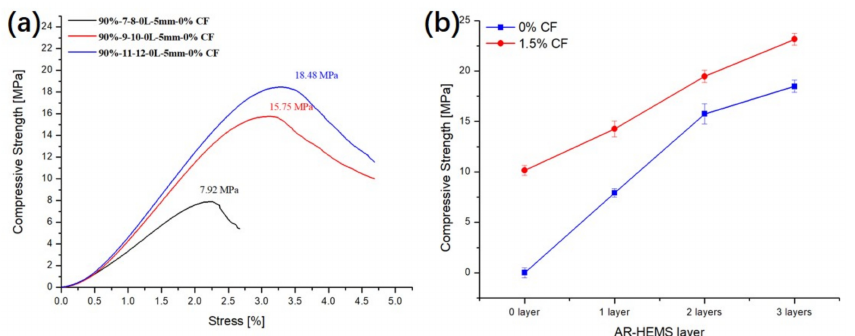
Figure 16. Influence of the addition of CF in EP-HGMS on the compressive properties of ESF with AR-HEMS with different